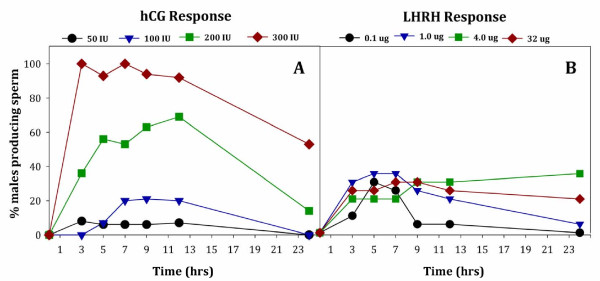
Percentage of male Anaxyrus americanus producing sperm over 24 hrs after hormone administration with either hCG (Panel A; n = 16/trt) or LHRH (Panel B; n = 20/trt). Male toads were treated with four different concentrations of hCG at 50 IU (circles); 100 IU (triangles); 200 IU (squares) or 300 IU (diamonds). Alternatively, males were treated with four different concentrations of LHRH at 0.1 μg (circles); 1.0 μg (triangles); 4 μg (squares) or 32 μg (diamonds).